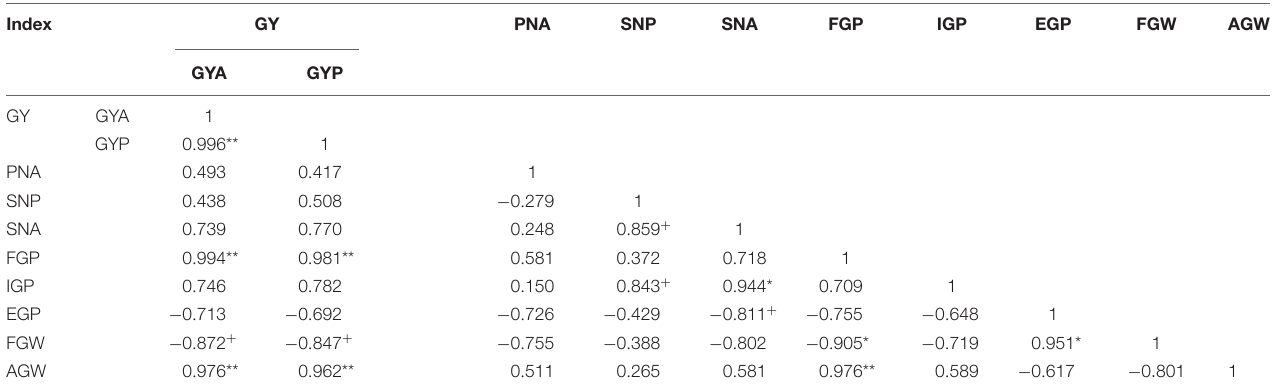
TABLE 2 | Relationships among the CO 2 -induced changes in yield, yield traits of five source-sink treats under elevated CO 2 . Index